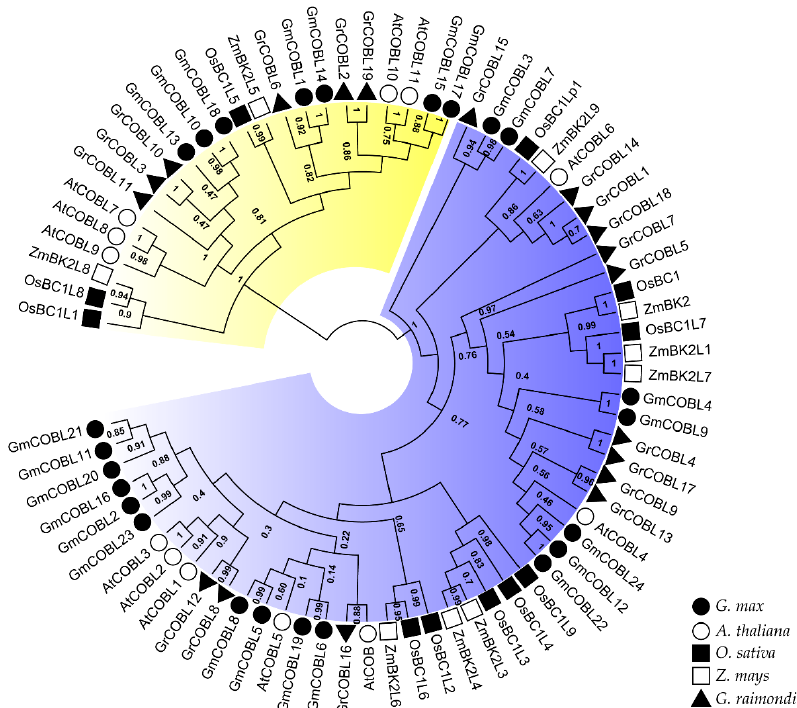
Figure 1. Phylogenetic relationship of COBL genes in soybean, Arabidopsis, rice, cotton, and maize. Multiple alignments of amino acid sequences were performed using ClustalW and the phylogenetic tree was constructed using MEGA X software by the Maximum Likelihood method. The value at the branches represents bootstrap values from 1000 replicates. Five species were represented by five different symbols. Different groups of the COBL family are indicated by colors. Blue is Group I and yellow Group II. Plants 2021 , 10 , x FOR PEER REVIEW